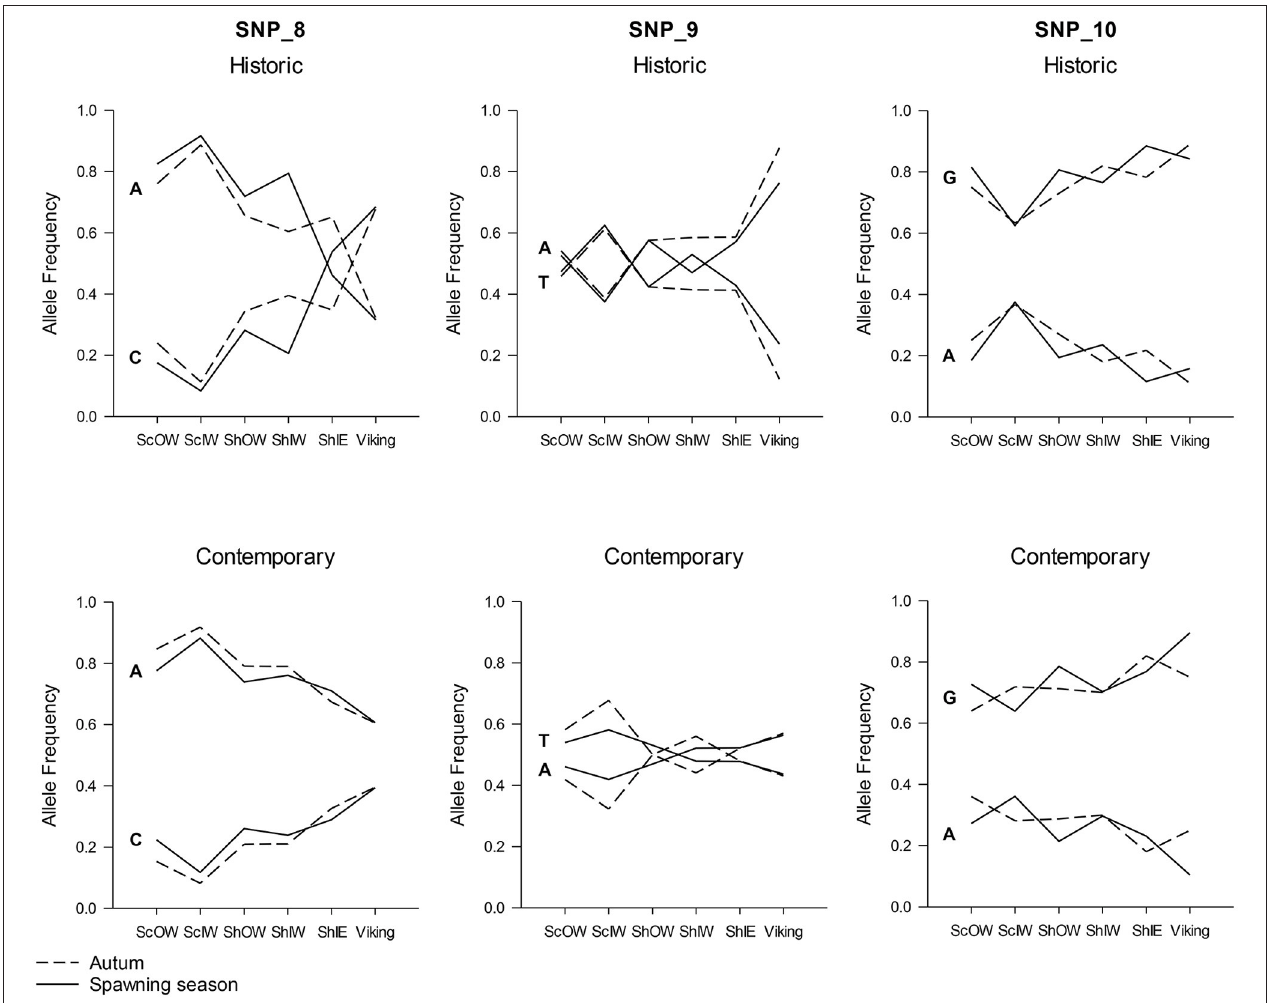
FIGURE 5 | Change in allele frequency in loci SNP_8, SNP_9, and SNP_10 in relation to sample location with the data separated into early (above) and contemporary (below) sample series as well as taken during the spawning season (solid line) and the Autumn (broken